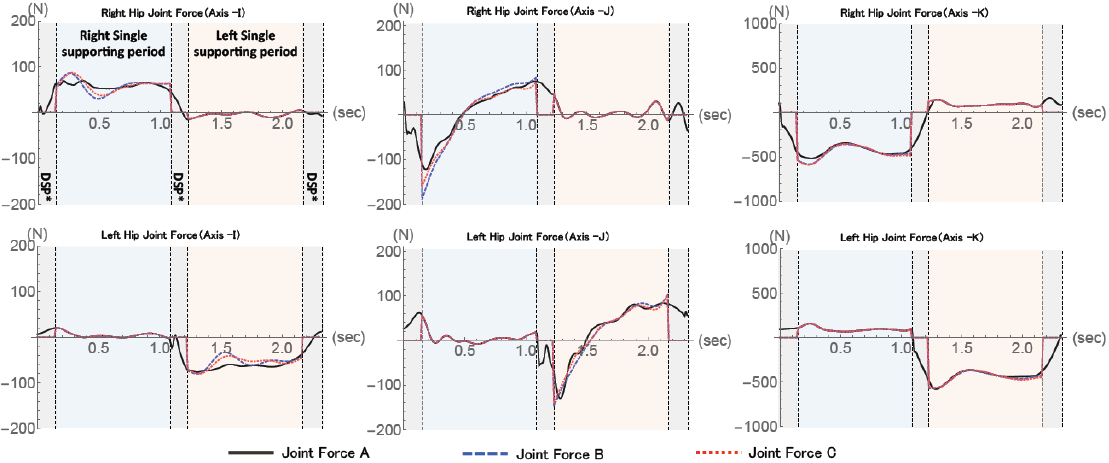
Figure 2. Comparison of Hip joint force. * DSP: Double supporting